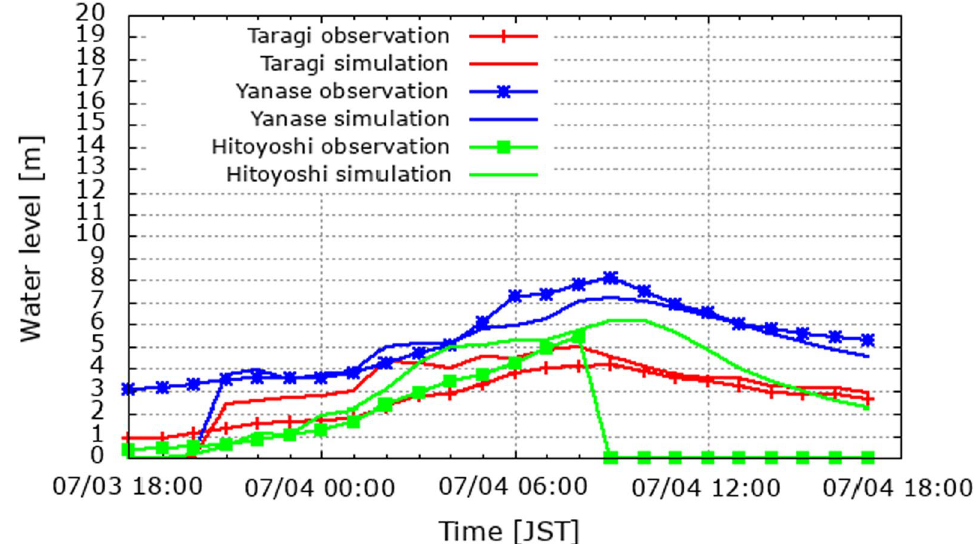
Fig. 7 Observed and simulated water depth at water level